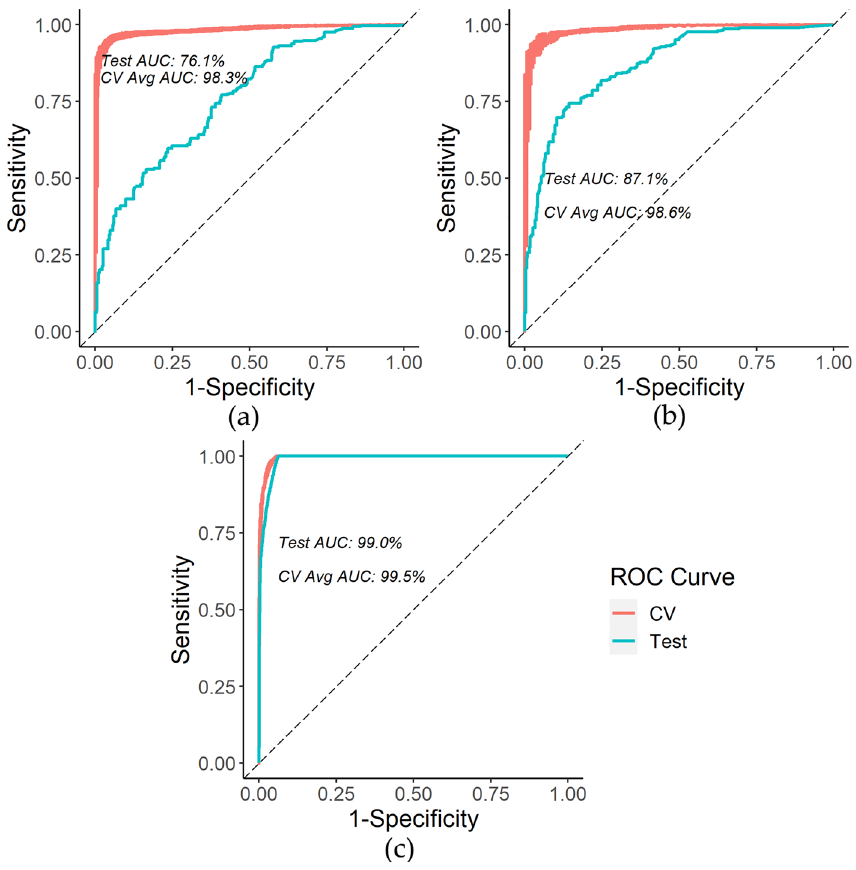
Figure 5. ( a ) Pediatric 30-year second tumor time-dependent ROC curve example; ( b ) Adolescent 30-year second tumor time-dependent ROC curve example; ( c ) Young adult 30-year second tumor time-dependent ROC curve